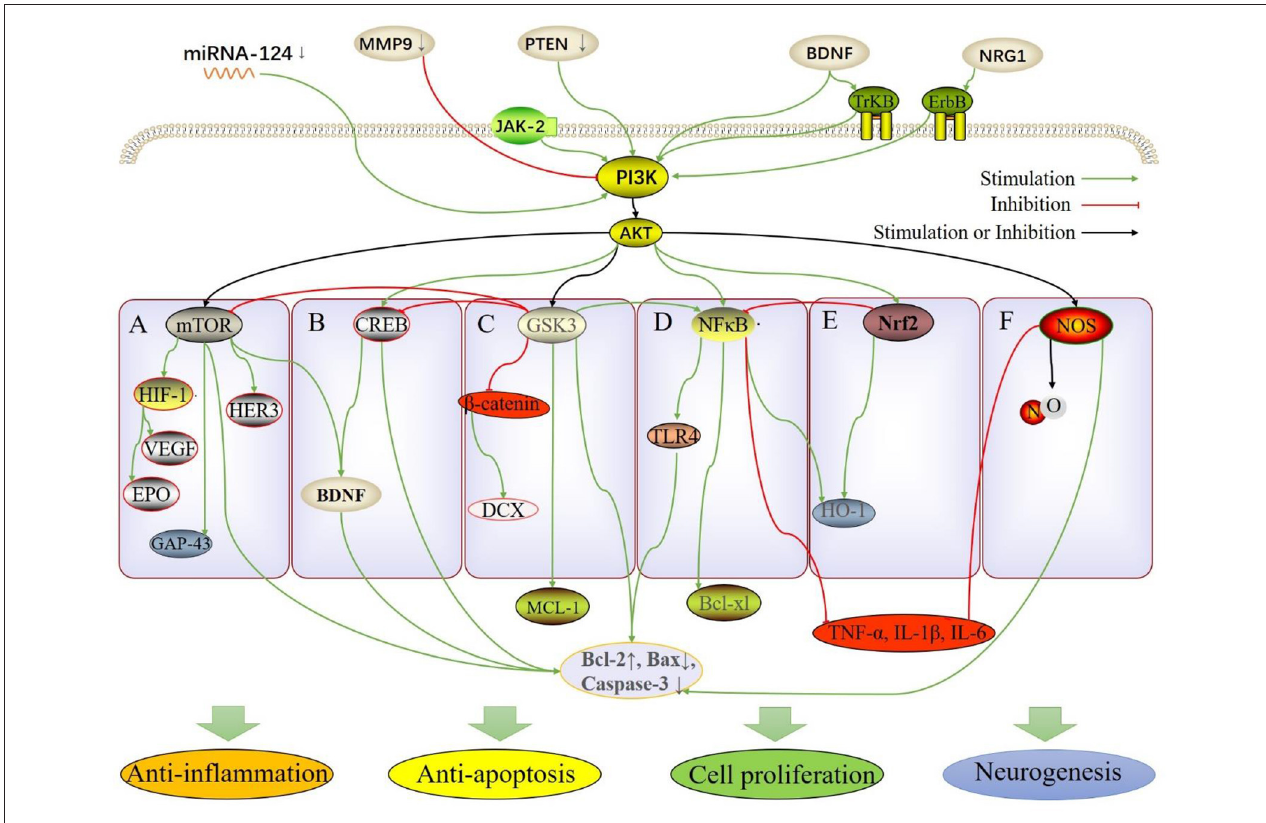
FIGURE 1 | The molecular and pathway mechanisms involved in the neuroprotective effect of TCM herbs, including anti-inflammation, anti-apoptosis, cell proliferation and neurogenesis. (A) PI3K/AKT/mTOR; (B) PI3K/AKT/CREB; (C) PI3K/AKT/GSK3; (D) PI3K/AKT/NF- κ B; (E) PI3K/AKT/Nrf2; (F)